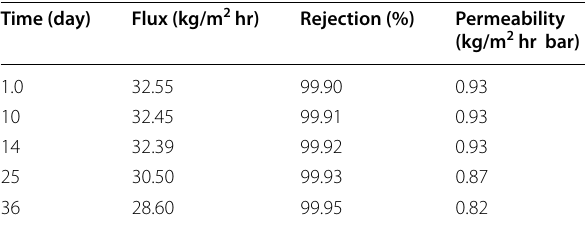
Table 2 Performance of prepared membrane at room temperature (feed Red Sea water sample 38528 ppm, 35 bar,